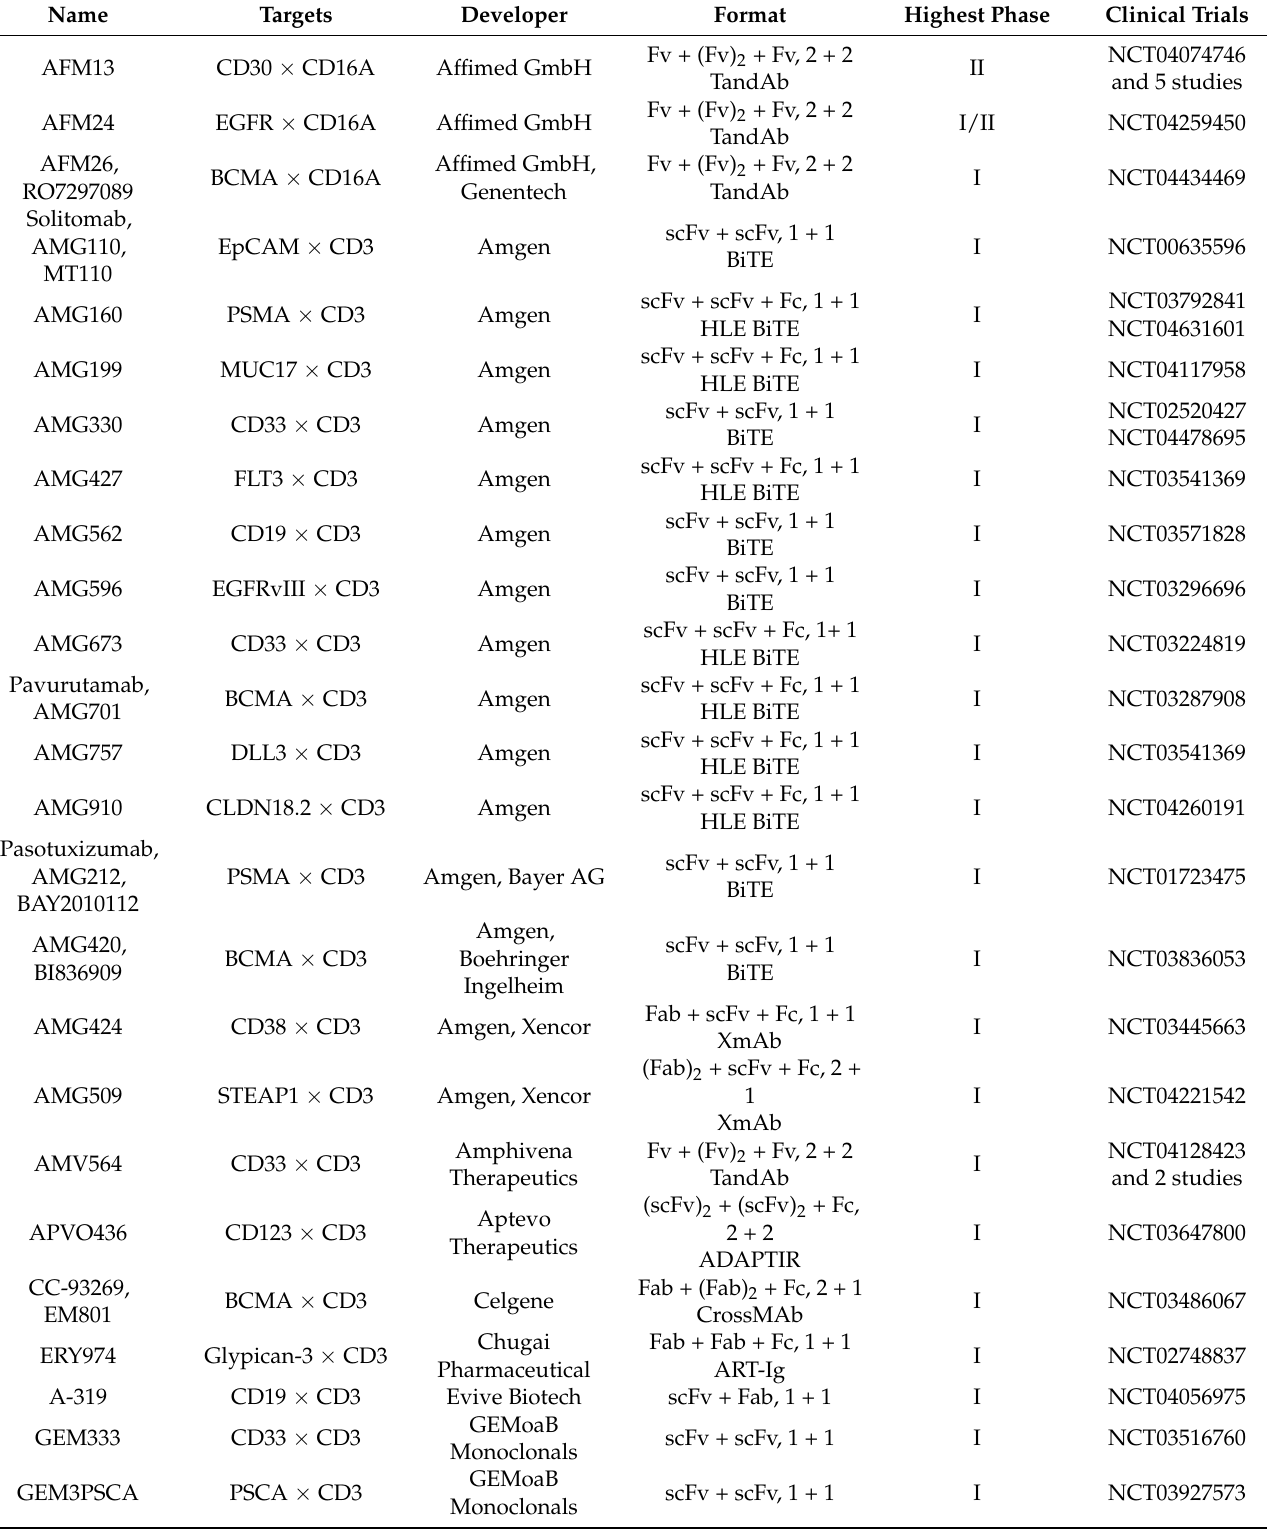
Table 2. Immune cell-engagers in clinical